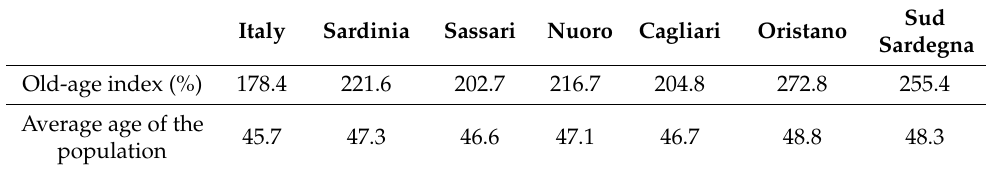
Table 1. Istat demographic indicators